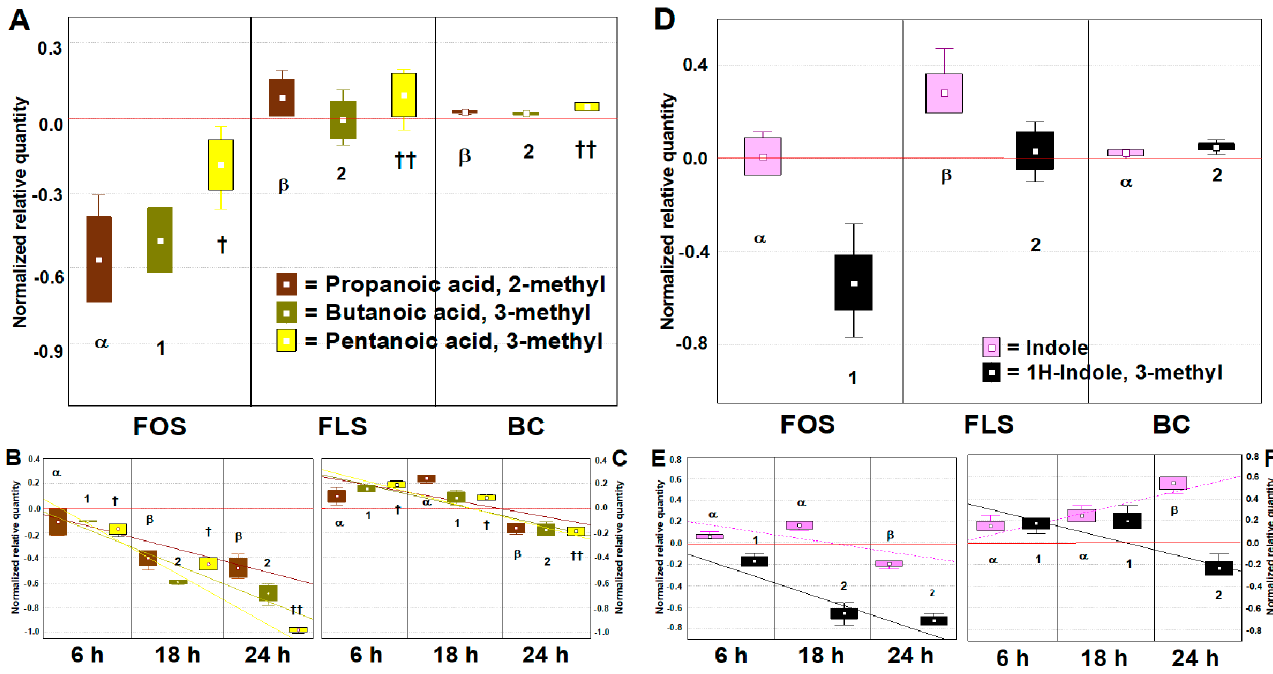
Figure 3. Changes in main microbial metabolites related to prebiotic activity expressed as a normalized scale from relative abundances in respect to the baseline value (BL = 0.0). FOS = Fructooligosaccharides; FLS = tested fiber; BC = Blank control. The bigger plots show changes over gathered time points, while the smaller plots show changes after specific time points, including tendency lines. The baseline absolute quantifications in mg/kg are found in the supplementary material (Table S1). Changes were recorded over and after 24 h of in vitro batch human colonic fermentations with 1% ( w / v ) FOS and FLS. Samples were analyzed in duplicate from two independent experiments ( n = 4). Boxes = mean; rectangles = mean ± S.D.; whiskers = non outlier range. Cases with different Greek letters, numbers, or symbols among a single dependent variable are significantly different by Tukey’s HSD test ( p < 0.05). ( A ) Shifts of Branched Chain Fatty Acids (BCFAs) during the fermentation time; ( B ) Shifts of BCFAs with FOS by time points; ( C ) Shifts of BCFAs with FLS by time points. Propanoic, 3-methyl acid ( p < 0.0011); Butanoic, 3-methyl acid ( p < 0.0012); Pentanoic, 3-methyl acid ( p < 0.0474). ( D ) Shifts of indoles during the fermentation time; ( E ) Shifts of indoles with FOS by time points; ( F ) Shifts of indoles with FLS by time points. Indole ( p < 0.0330); 1H-Indole, 3-methyl ( p < 0.0007).